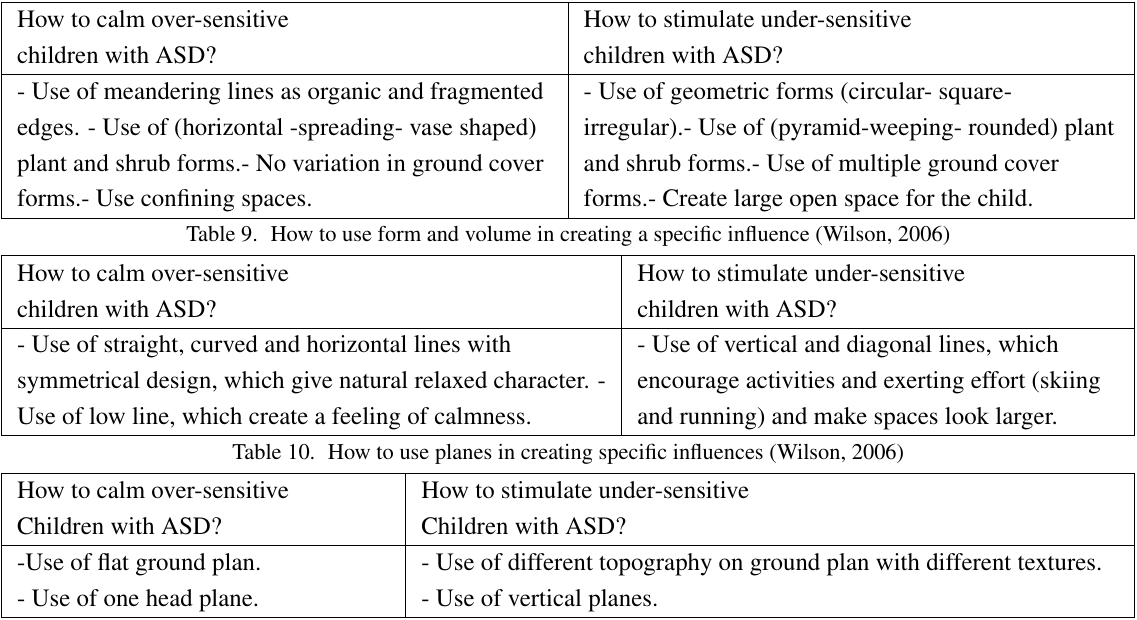
Table 8. How to use lines in creating specific influences (Wilson, 2006)